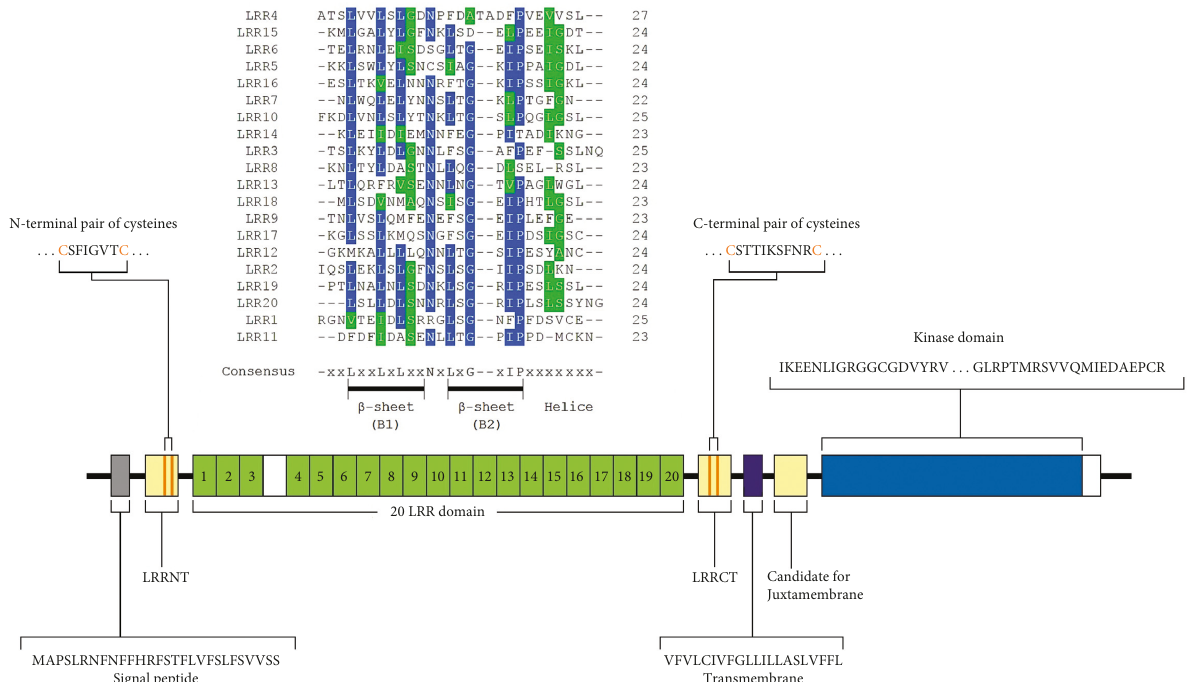
Figure 2: RLK7 functional domain. RLK7 carries a signal peptide, an ectodomain composed of twenty LRRs flanked by an amino (N) terminal cysteine pair and a carboxy (C) terminal cysteine pair, a single transmembrane domain followed by a potential juxtamembrane domain candidate, and a kinase domain. The cysteine pairs are colored in orange. LRRNTand LRRCTare the LRR N-terminal domain and LRR C-terminal domain, respectively. The alignment of the twenty LRR domains is shown above. The gaps represent the spaces introduced for better alignment. The identical and similar amino acids are boxed in blue and green, respectively.